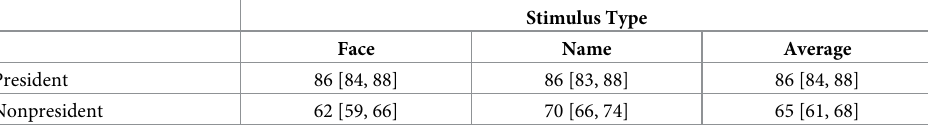
Table 6. Mean confidence ratings for correctly responding “president” to a name versus a face in Experiment